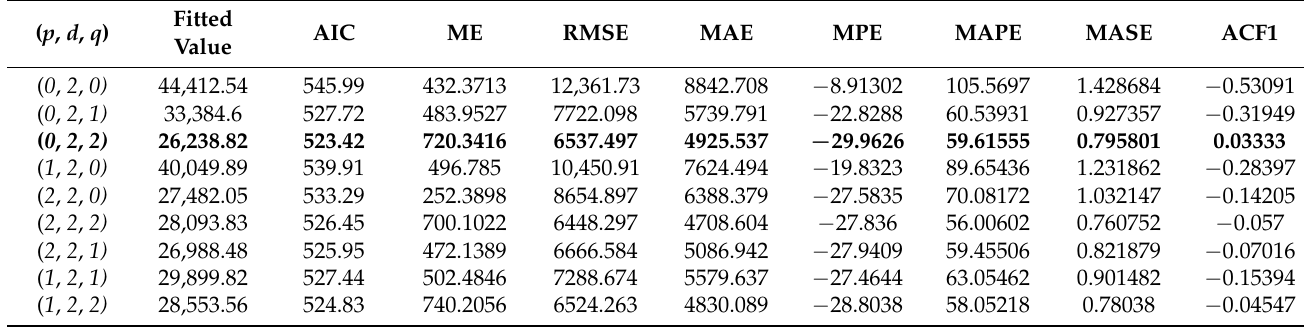
Table 3. Comparison of fitted values and evaluation parameters for different ARIMA models.